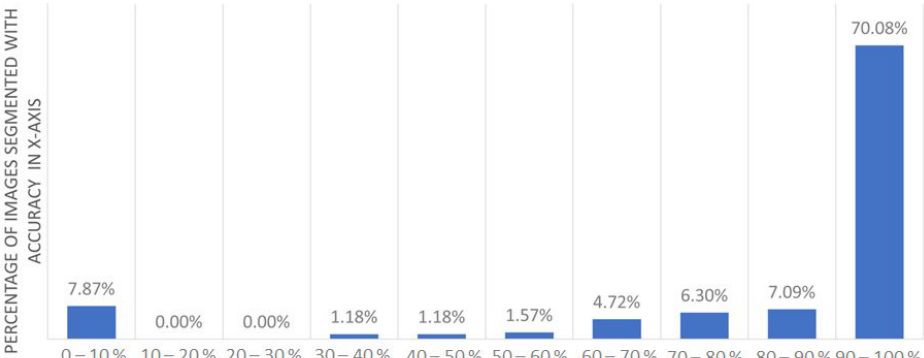
Figure 8. Segmentation accuracy is calculated using IoU metric for 254 DICOM scans.